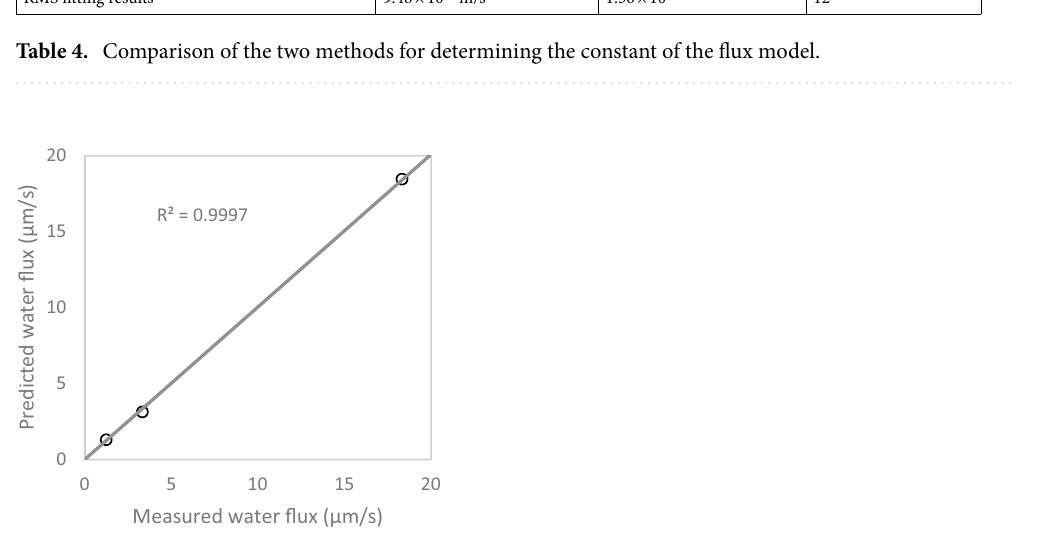
Figure 4. Parity line graph of simulated flux plotted against the measured flux — OARO experiment by Askari et al. 3 , under 30 bar hydraulic pressure, with equal permeate and retentate bulk concentrations of 0.035, 0.6